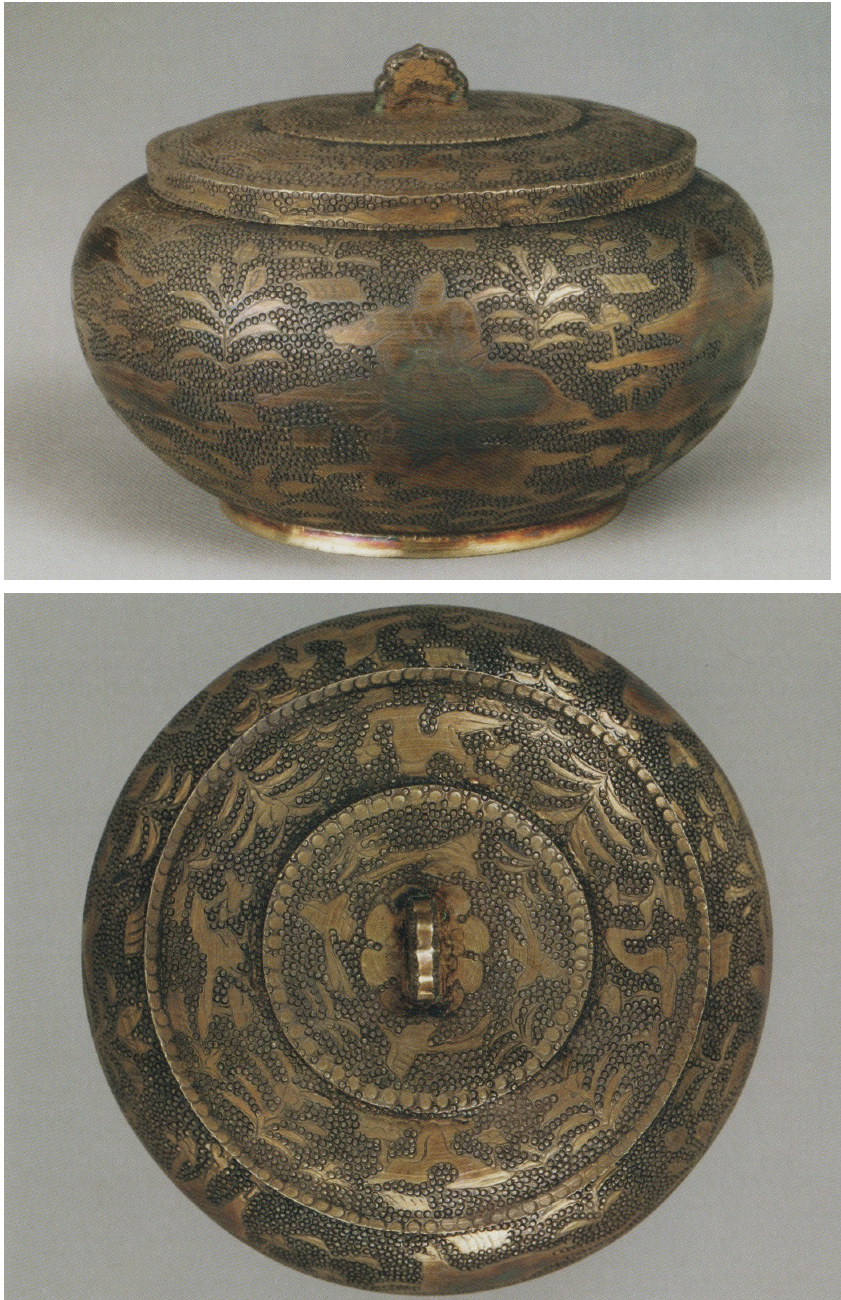
Figure 10. Silver lidded jar with hunting scene. Discovered from the southwest location from be- Figure10. Silverliddedjarwithhuntingscene. Discoveredfromthesouthwestlocationfrombeneath neath the Seated Vairocana Buddha, T ō daiji. Nara period, mid 8th century. In the collection of the Seated Vairocana Buddha, Tōdaiji. Nara period, mid 8th century. In the collection of Tōdaiji Cultural Center. Reproduced from Tōdaiji Myūjiamu (2013, p.